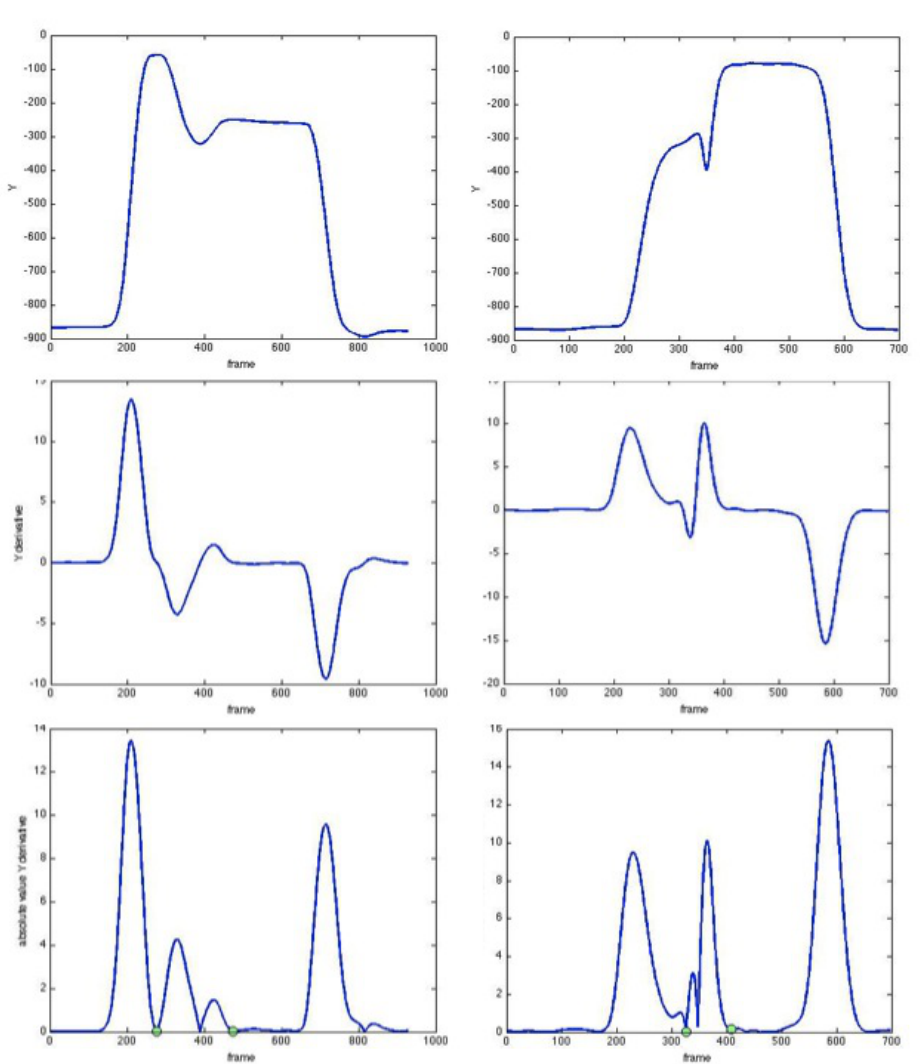
Figure 5. On the left, the signals of the gesture "revere". On the right, the signals for "accept". From top to bottom: positions of the index for Y, speed (derivative) and absolute value of the speed with automatic individuation of the stroke between two green points.